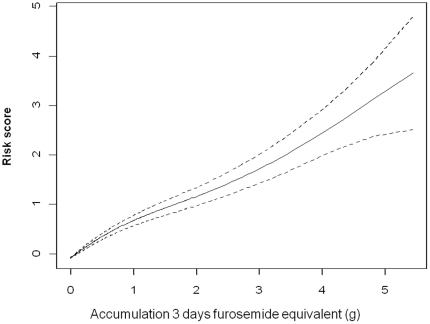
Accumulated diuretics dose predicts post dialysis mortality.Time-varying three-day accumulative diuretic dose (equivalent to furosemide dose) predicts 30 days mortality after undergoing acute dialysis. The smoothed plot of a generalized additive model included all demographic variables in the time-varying analyses, plus comorbid states (p<0.001).